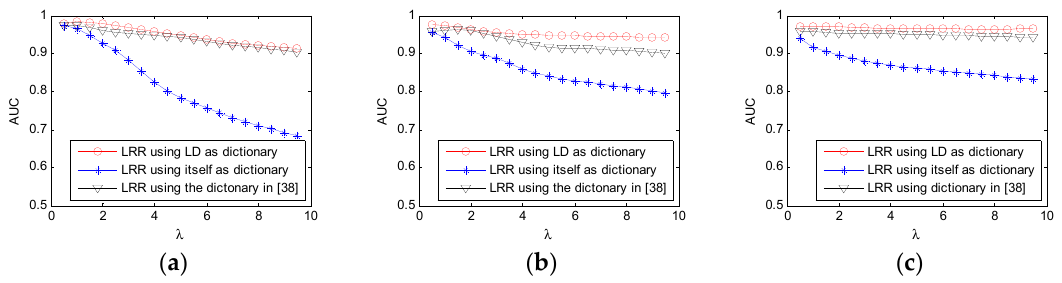
Figure 8. AUC with different tradeoff parameter λ under complex background using different dictionaries: ( a ) F1; ( b ) F2; and ( c ) V1.